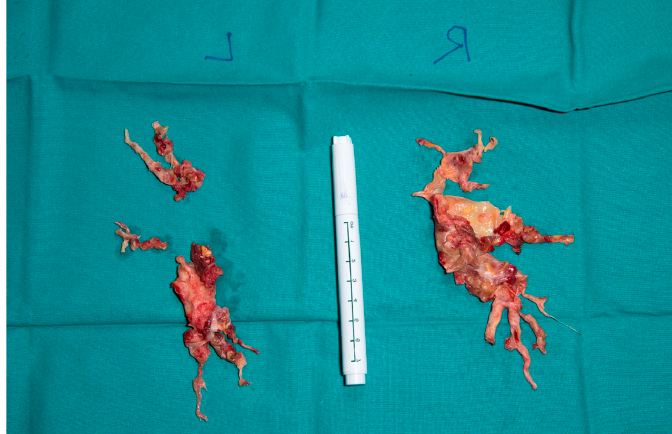
Figure 5. Right and left sided thrombendartherectomy specimen. Right : Rudimentary upper lobe specimen and lower lobe branches are depicted, and fresh emboli chronic material is clearly visible (red arrows). Left : Superior segment and basal lower lobe segment specimen.